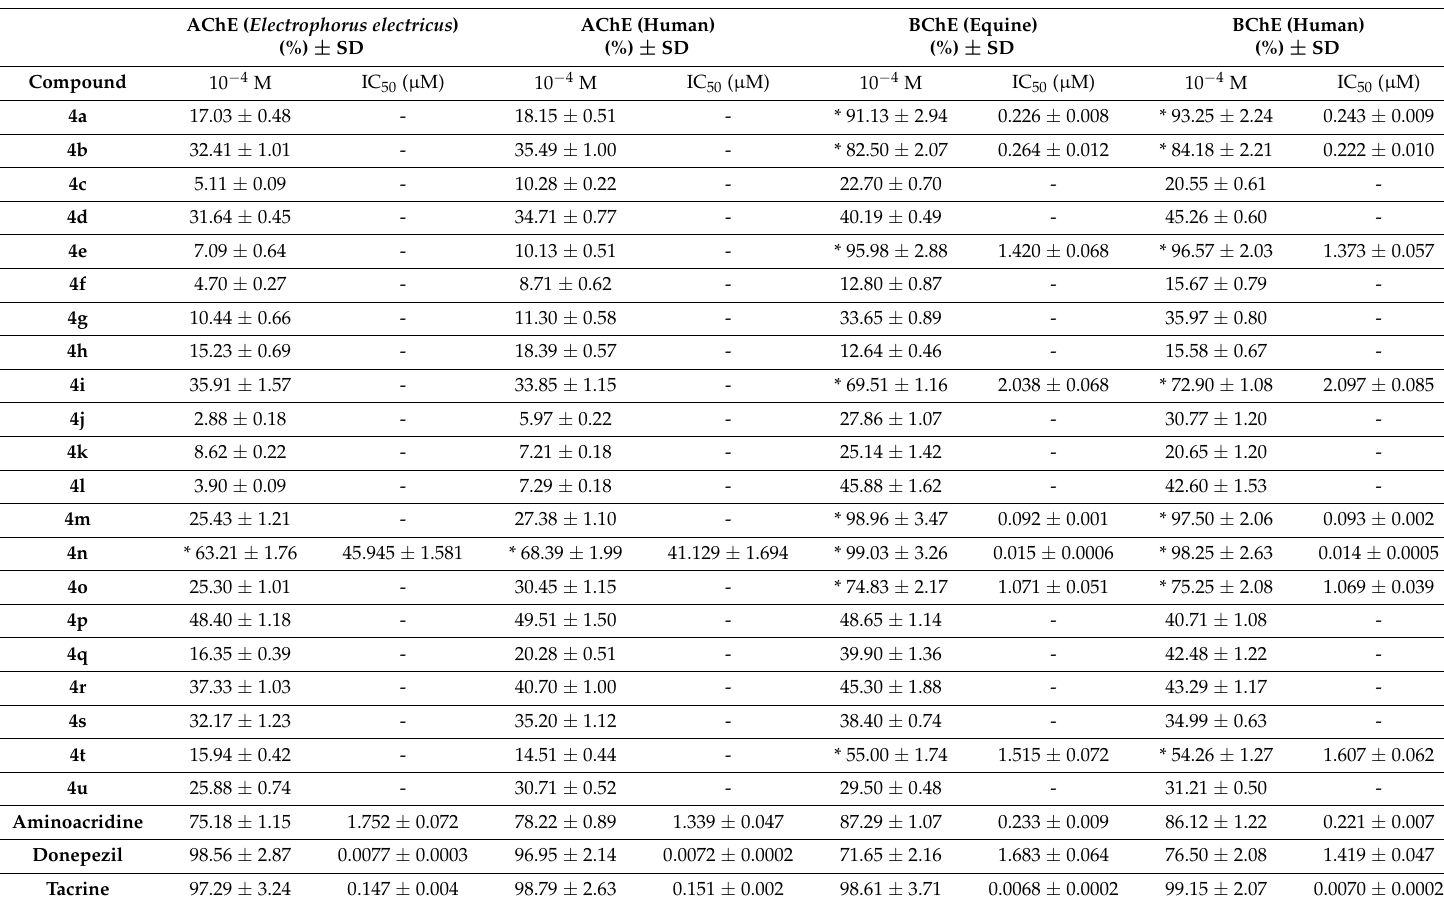
Table 1. Inhibitory activity (%) of compounds 4a – 4u against acetylcholinesterase (AChE) and butyrylcholinesterase (BChE) enzymes at 10 − 4 M concentration and their half maximal inhibitory concentration (IC 50 ; µ M) values against these